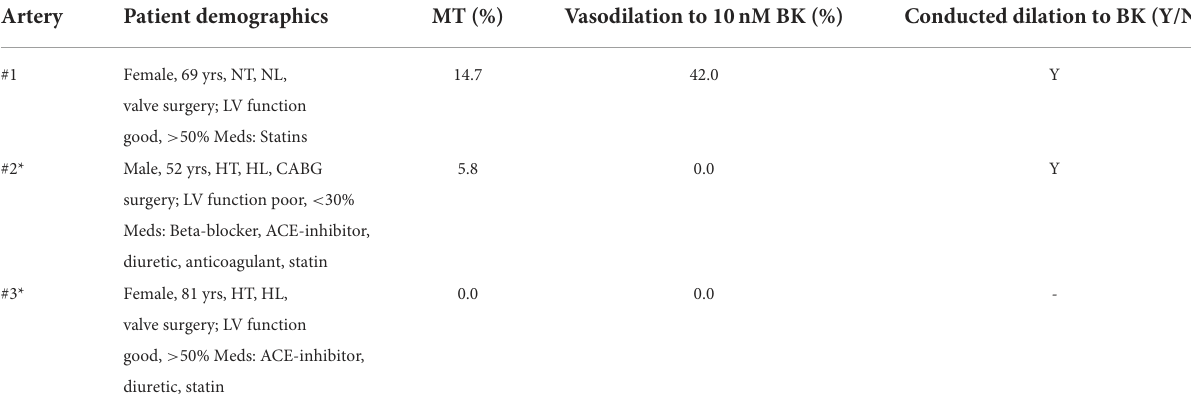
TABLE 2 Human RA-IMCAs processed for SBF-SEM arteries ( n = 3).